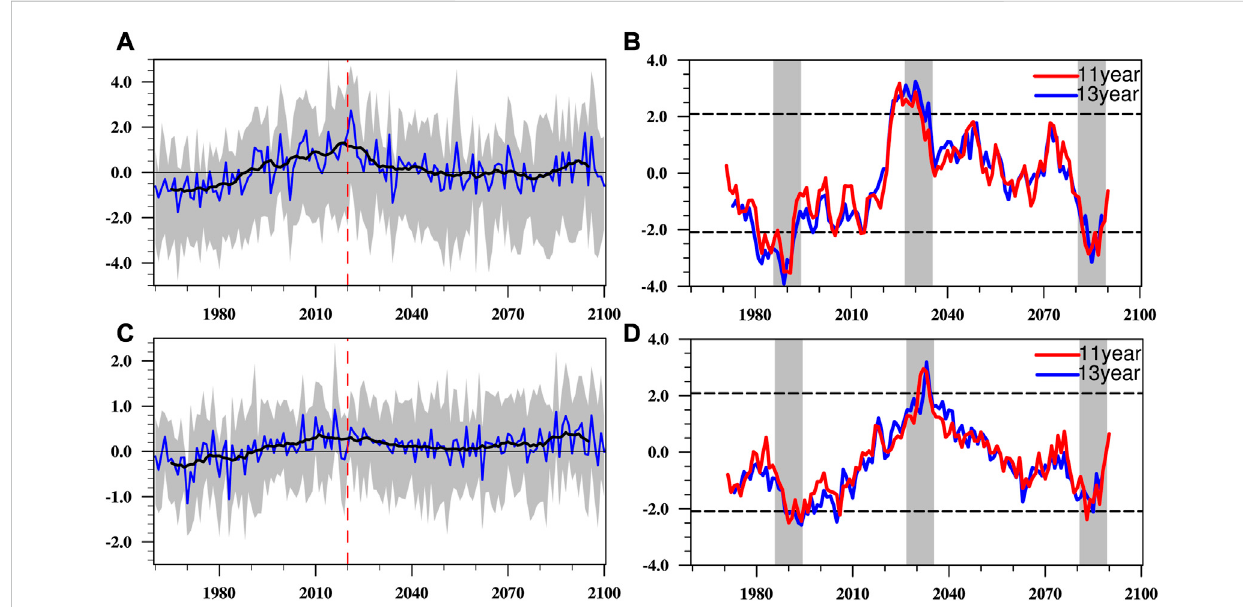
FIGURE 7 Thebluelinesindicatethe (A) CDDAindexintheCESM-LEMMEand (C) ZWI-LEduring 1960 – 2100relativetothepresentclimate(1960 – 2019).The shadings in (A,C) indicate the ensemble spread ranging from the 25th to 75th quantiles. The black lines indicate the 11-year running mean of the corresponding time series. The moving t -testof the (B) CDDA indexin theCESM-LEMME and (D) ZWI-LE during 1960 − 2100, with window lengths of 11- year(redline)and13-year(blueline).Theblackhorizontaldashedlinesindicatethe95%con fi dencelevel.Theshadingsin (B,D) indicatetheperiodof signi fi cant interdecadal